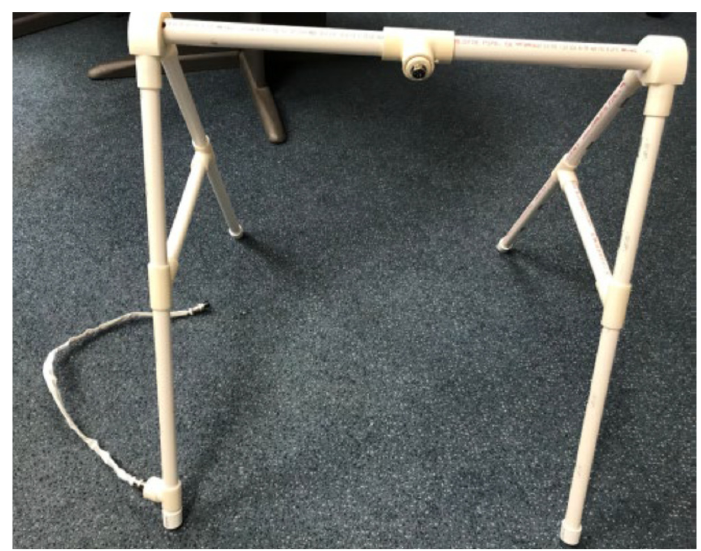
Figure 1. HUGS-1 A-frame for instrumented